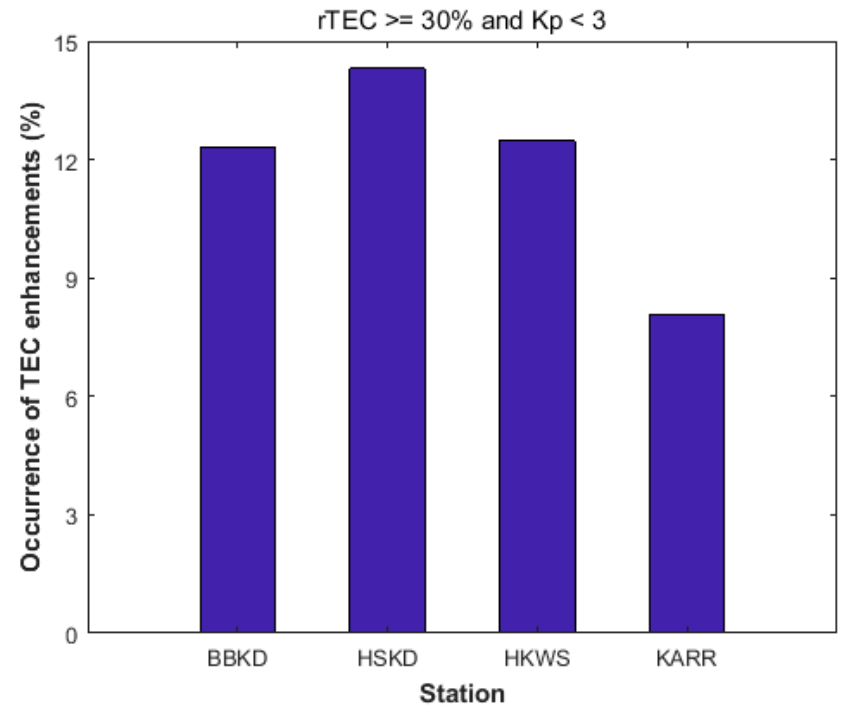
Figure 6. The station distribution of the TEC enhancements occurrence under Kp < 3 during 2016–